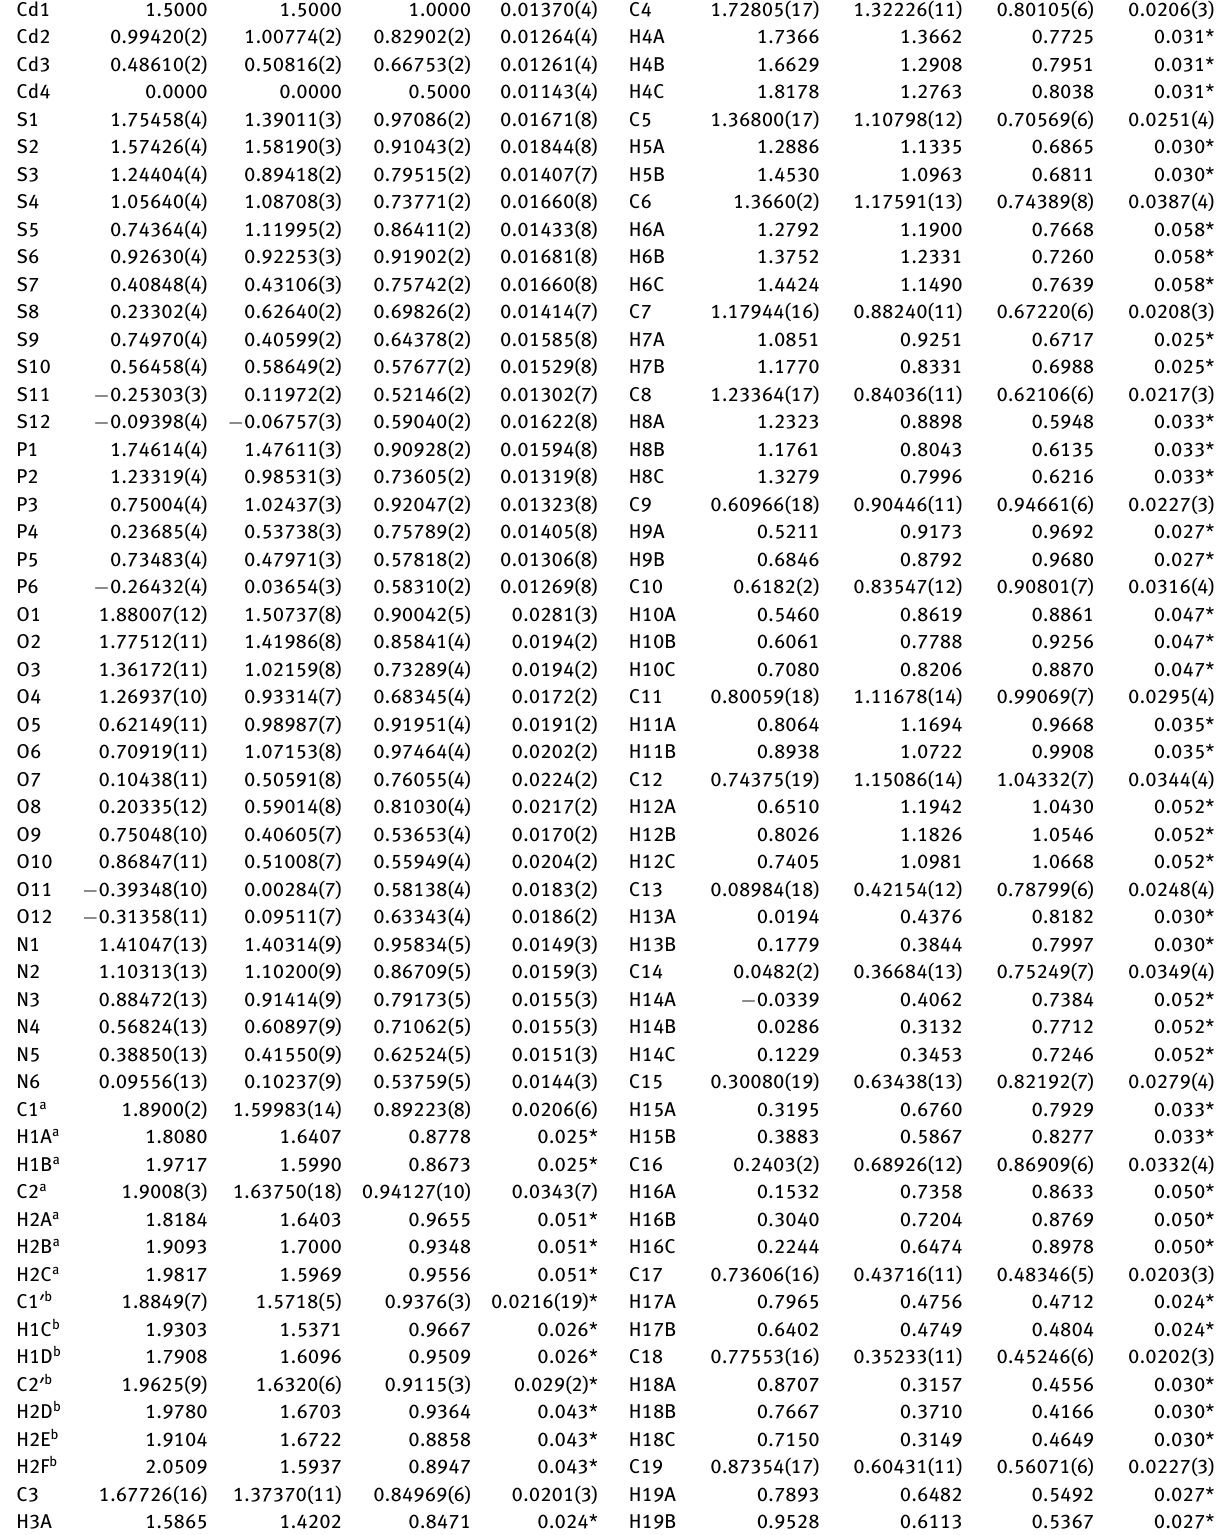
Table 2: Fractional atomic coordinates and isotropic or equivalent isotropic displacement parameters (Å 2